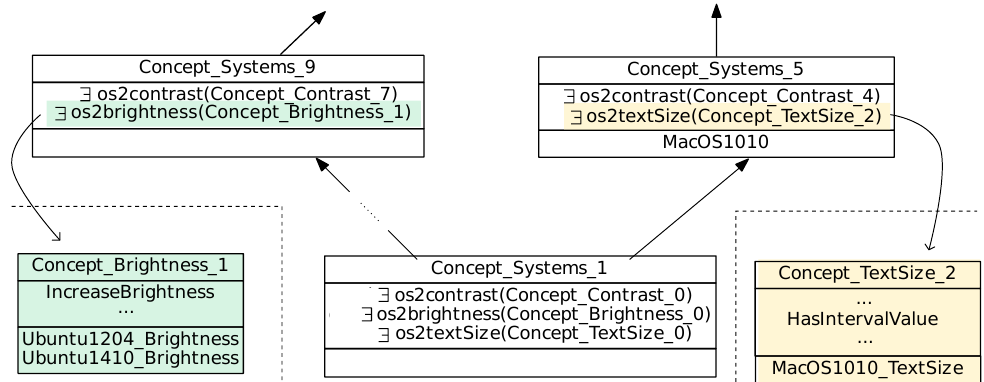
Figure 12. Excerpt of several concept lattices (redrawn from the lattices output of the tool for the sake of explainability) to illustrate mutex in the central